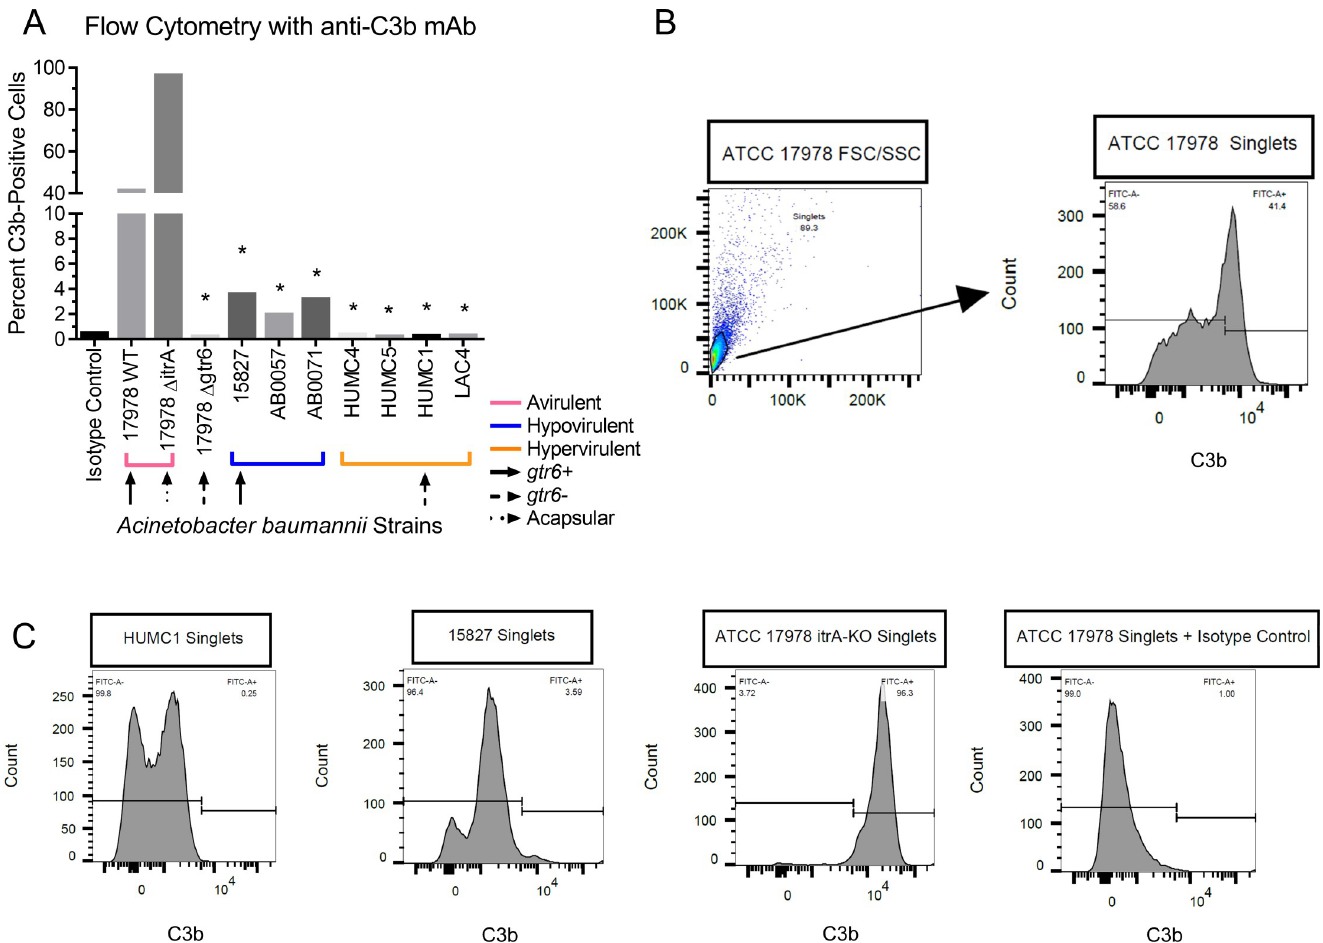
Fig 7. Flow cytometry of strains incubated with serum and anti-C3b antibodies. (7A) Flow cytometry of bacteria following incubation in 10% complement active serum followed by anti-C3b antibodies. Strains denoted by known virulence (brackets) as well as gtr6 phenotype (upward arrows). p < 0.0001. (7B) Representative flow plot of initial forward and side scatter plot and sub-gating on single bacterial cells with FITC-A as the anti-C3b fluorophore. (7C) Representative histograms of anti-C3b fluorescent bacteria for HUMC1 (hypervirulent), 15827 (hypovirulent), ATCC 17978 Δ itrA (avirulent), and the isotype control. 20,000 events collected per condition for flow cytometry, gated for singlets via FSC/SSC, fluorescence gate set to exclude 99% of isotype control and copied across samples ran in parallel.